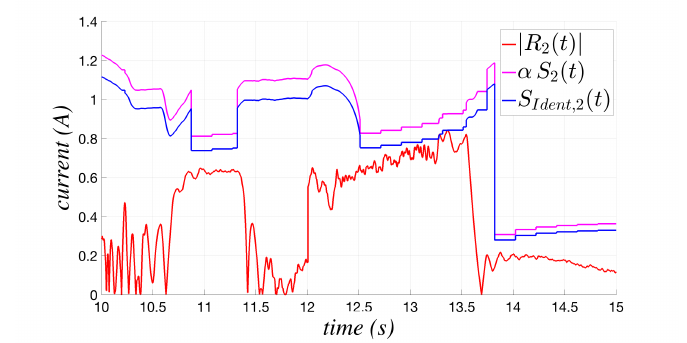
Figure 14. Behavior of threshold functions and current residue during the adaptation phase for the second joint of an NS12